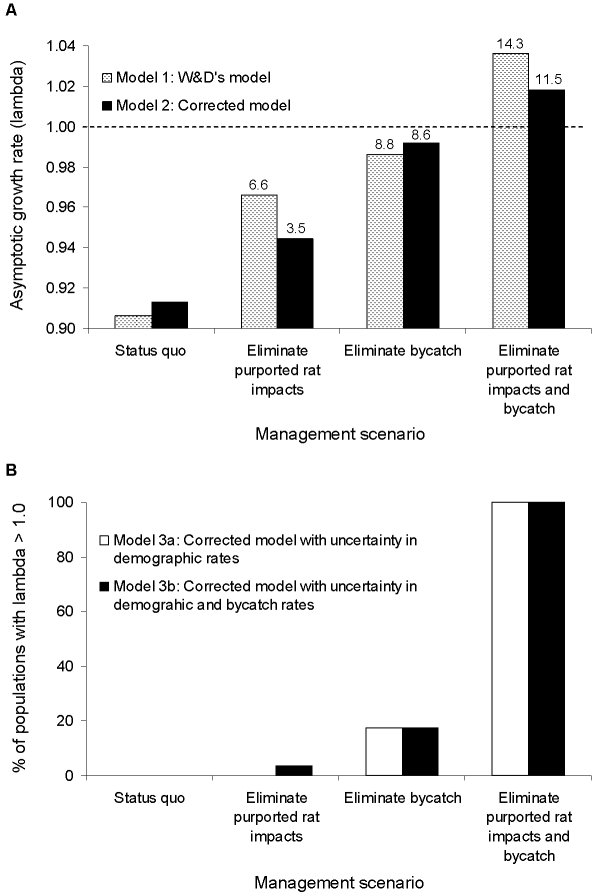
Bycatch elimination consistently yielded greater increases in flesh-footed shearwater (Puffinus carneipes) population viability than reducing pre-fledging mortality.A) Predicted asymptotic growth rate (λ) for flesh-footed shearwaters on Lord Howe Island under four management scenarios, using either Model 1, the model described by W&D [6] or Model 2, our corrected model. Values above bars give percentage increase in λ relative to the status quo. Dotted line is λ = 1 (a stable population). B) The percentage of 10,000 replicate matrices for which predicted λ exceeds 1.0 using our corrected model with the inclusion of uncertainty only in demographic rates (Model 3a) or in both demographic and bycatch rates (Model 3b). A λ>1.0 is necessary for a recovering population (see Supplement S1 for detailed description of modeling assumptions, procedures, and results).